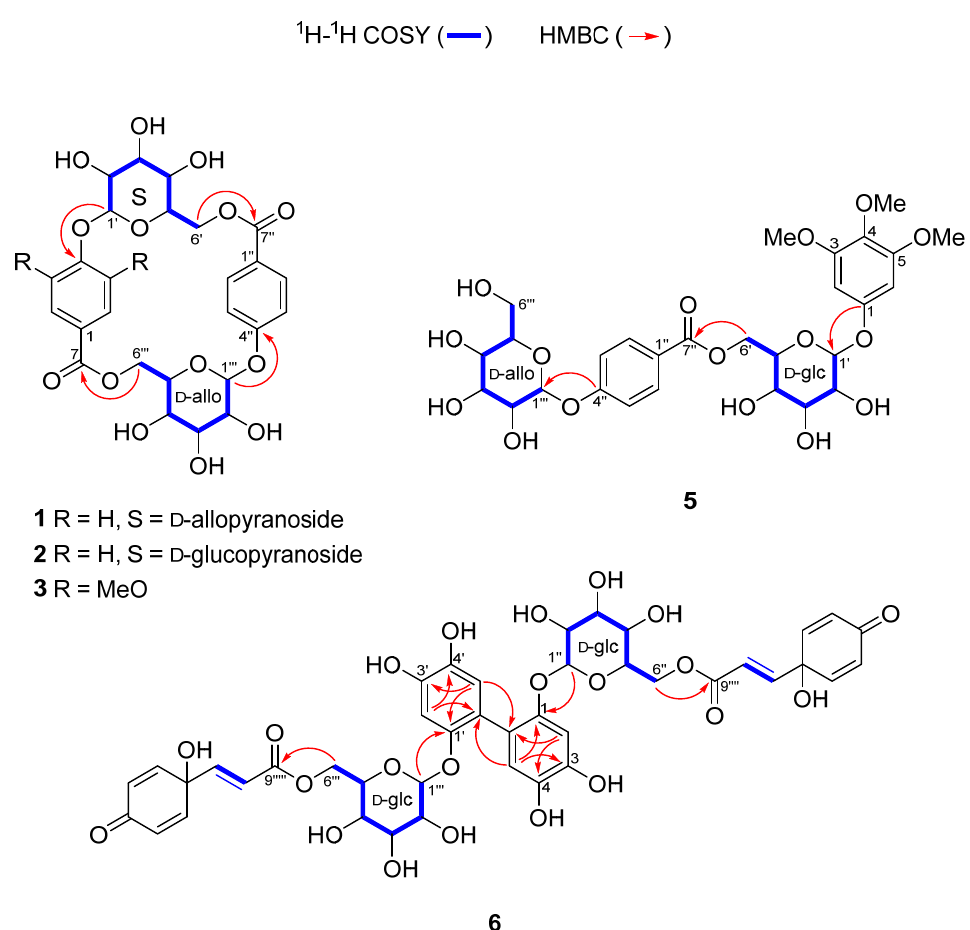
Figure 2. Key 1 H − 1 H COSY and HMBC correlations for compounds 1 – 3 , 5 and 6 .